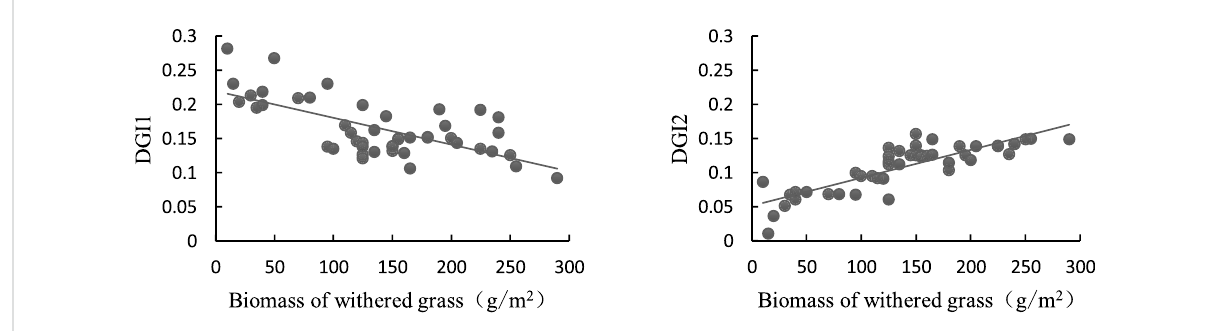
FIGURE 2 Scatter plots showing the amount of combustibles and the DGI values for construction of the dry-grass biomass model.